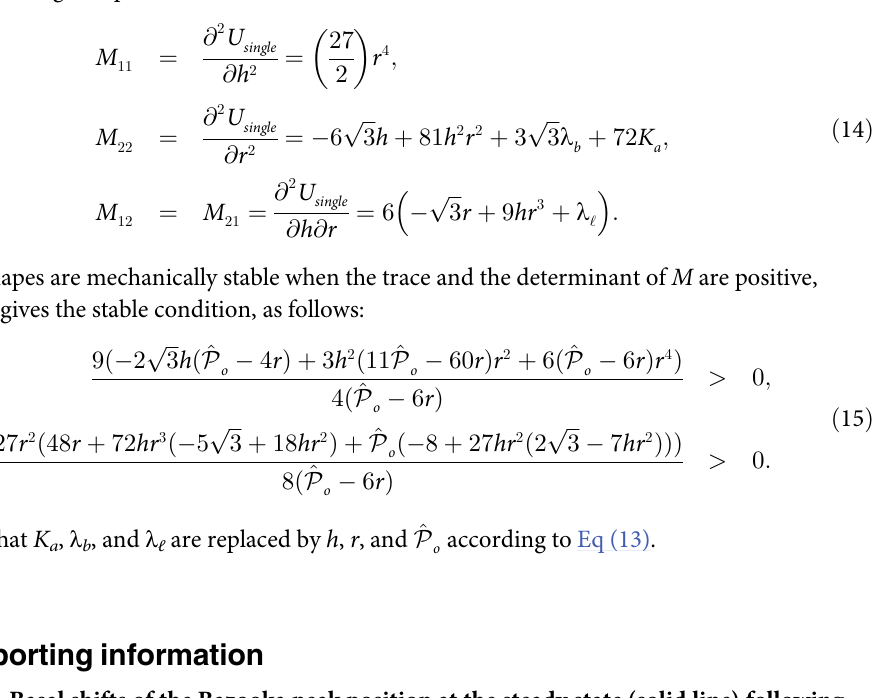
S1 Fig. Basal shifts of the Bazooka peak position at the steady state (solid line) following an increase in L as compared to the control (dashed line). Note that the polarity distribution is plotted on the scale of absolute value of membrane location in contrast to Fig 3B where the membrane location is scaled by L . S2 Fig. Epithelial deformation induced by modulation of mechanical parameters in a 3D vertex model. (A) A folded tissue structure forms when the apical mechanics, K and ^ P (left), a o or the basal–lateral mechanics, λ and λ (right), of a local cell population (yellow) is modu- b ℓ lated. The fold depth D is calculated as the difference between the highest and the lowest verti- ces on the apical surface, where D > 0 ( D < 0) indicates inward (outward) folding. (B) Cell deformation patterns in response to modulation of the apical (left column), basal (middle col- umn), or lateral cell mechanics (right column). For columnar ( � ; a / h = 0.25), cuboidal ( 4 ; a / h = 0.50), and squamous ( □ ; a / h = 1.50) shapes, basal length b (top) and cell height h (bottom) are plotted against apical length a at the steady state for different values of mechanical parame- ters. The color bars indicate the relative deviation of parameter values from those of the flat epithelium, where the mechanics ^ P , λ and λ are either increased or decreased for all b ℓ o